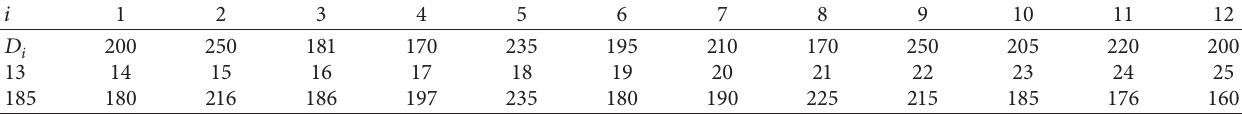
Table 5: Nominal demand of blood demand points in disaster areas.